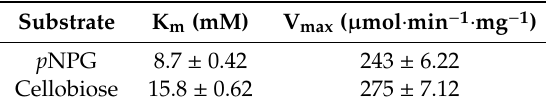
Table 12. Kinetic constants determined for purified β -glucosidase activity towards pNPG and cellobiose, as determined by non-linear regression analysis, using GraphPad Prism 7 (GraphPad Software, San Diego, CA,